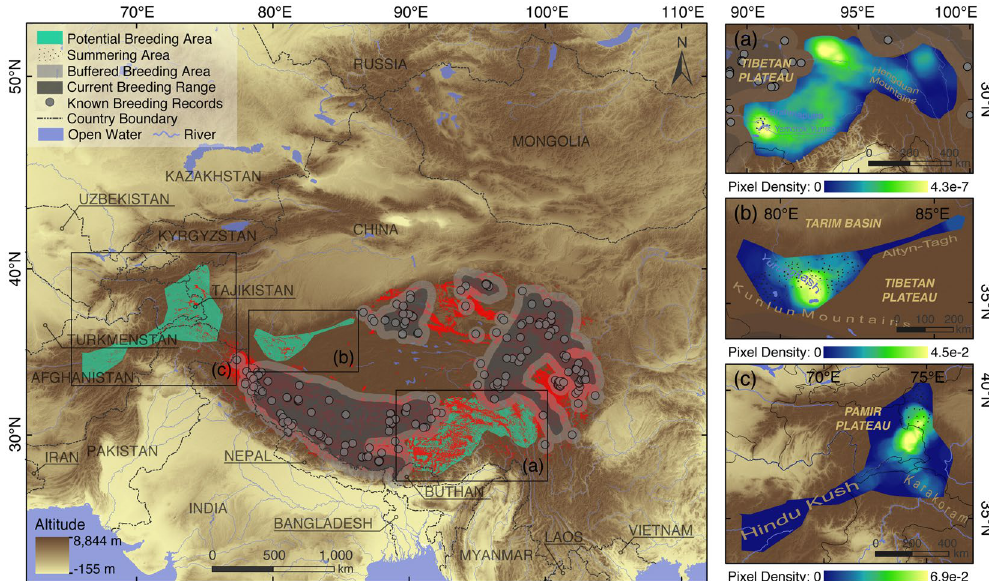
Figure 3. Map of potential breeding area. The map shows the potential breeding habitats of the black-necked crane, including ( a ) the northern parts of the Hengduan Mountains and the southeastern Tibet Valley; ( b ) the northern side of the middle Kunlun Mountains; and ( c ) parts of the Pamir Plateau, the northern Pakistan Highlands and the western Hindu Kush. The maps were made by the authors in ArcGIS 10.1 (ERSI co., USA) and processed in Adobe Illustrator CC (Adobe Systems Inc.,